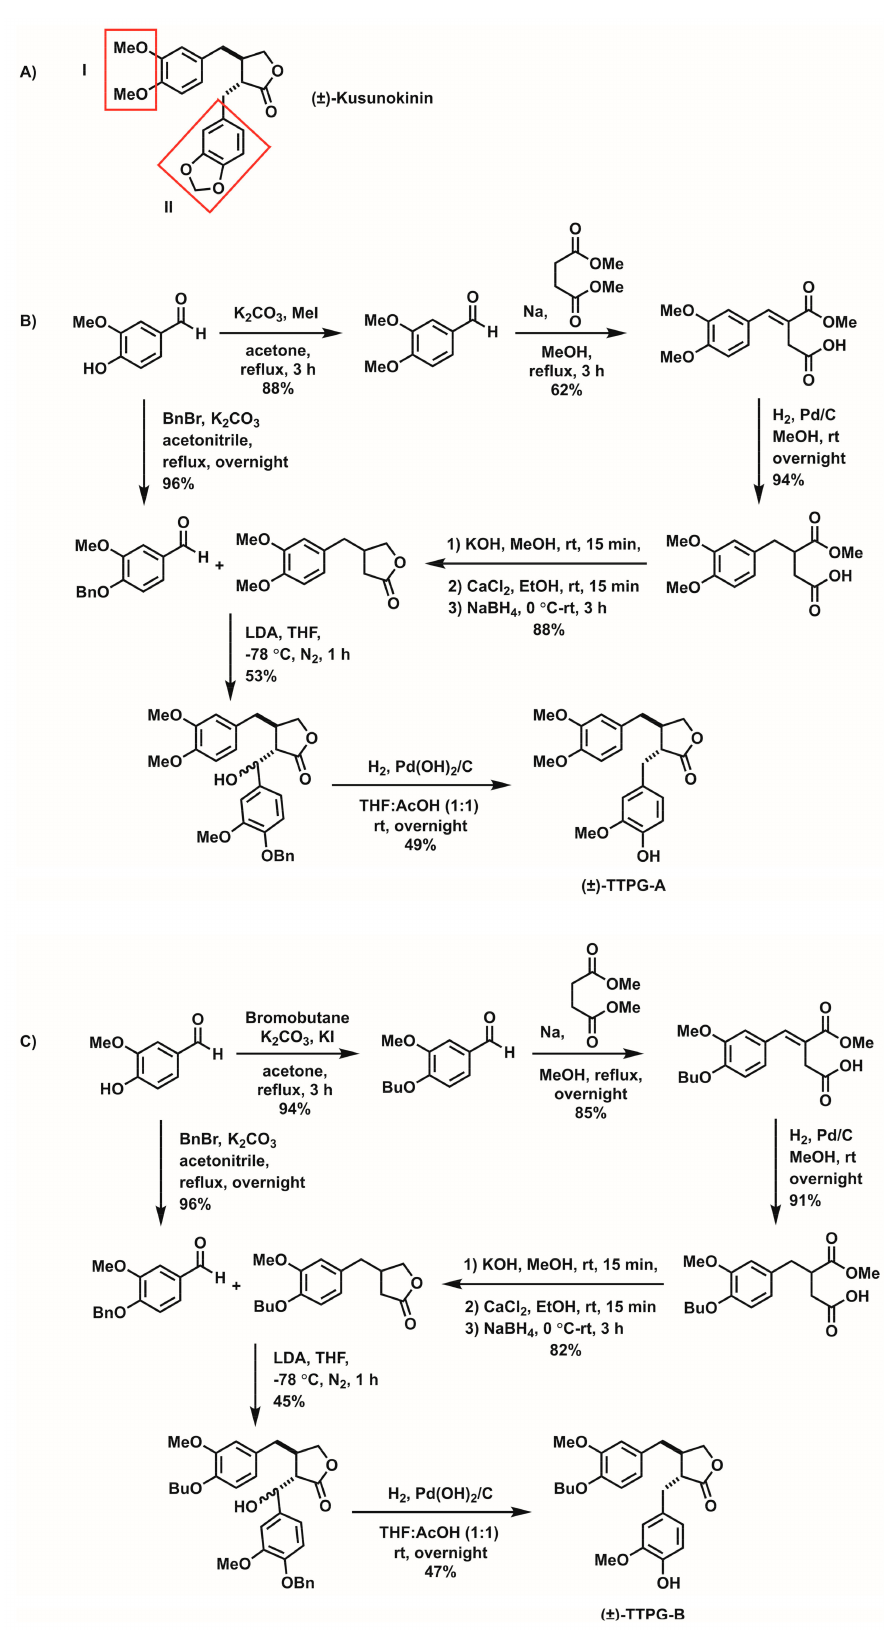
Figure 1. The chemical structure of ( A ) ( ± )-kusunokinin and the synthetic pathway of ( B ) ( ± )-TTPG- A and ( C ) ( ± )-TTPG-B. The chemical structures of ( ± )-TTPG-A and ( ± )-TTPG-B were modified at (I) the 3,4 dimethoxybenzyl butyrolactone part and (II) the 1,3-benzodioxole